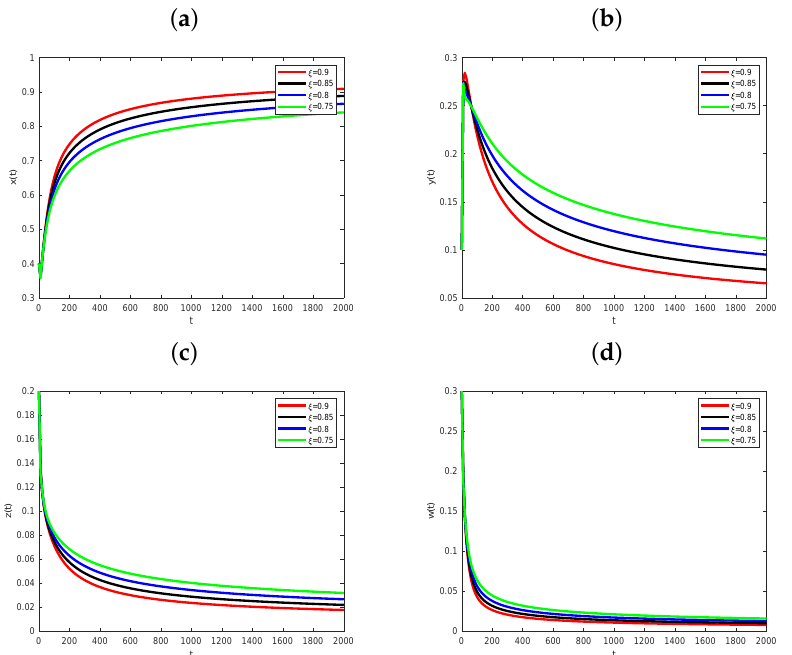
Figure 2. Graphs for the numerical solution of the fractional-order model investigated in this work. The graphs were obtained using the numerical method introduced in the previous section, and they provide the dynamics of ( a ) x vs. t , ( b ) y vs. t , ( c ) z vs. t , and ( d ) w vs. t . The parameters employed to produce these simulations were those provided in Table 1 for the endemic case. As indicated by the legends, various differentiation orders ξ were